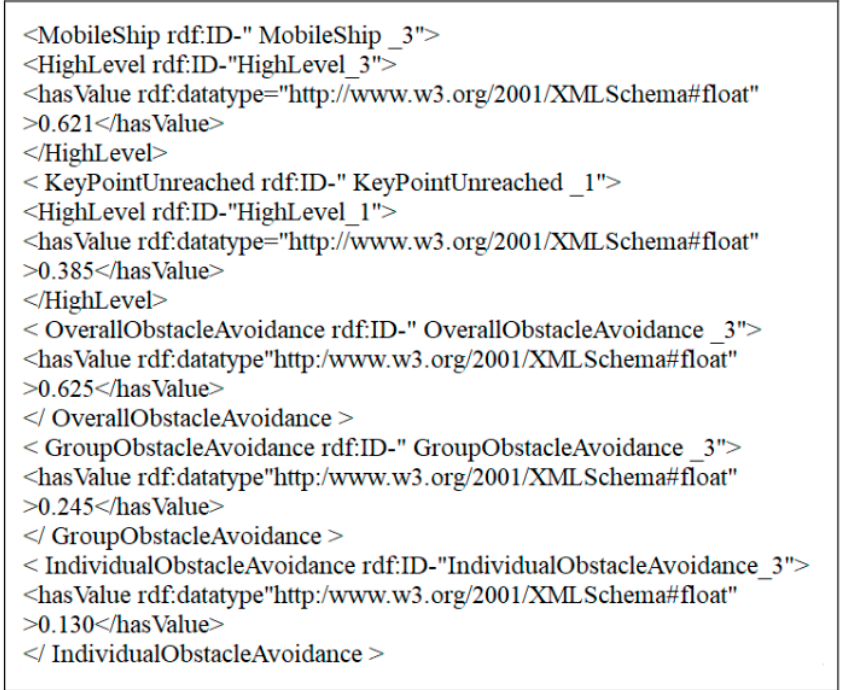
Figure 14. OWL format file.